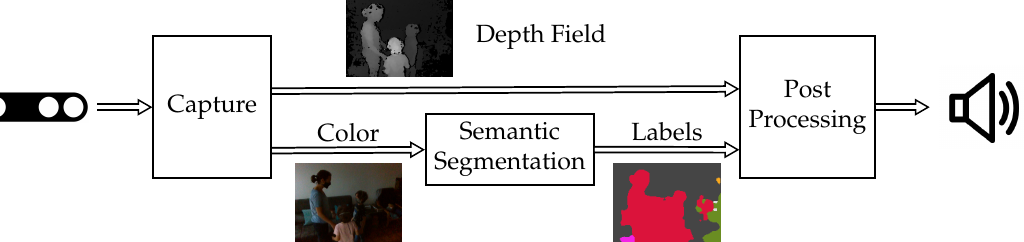
Figure 4. Software architecture. The capture module is implemented in C++ and provides aligned depth and color images. The color image is used by the semantic segmentation module, coded in PyTorch, to generate pixel-wise object class labels. The post-processing module combines the depth field and the label information to provide alerts only for close persons. Communication is handled by the Robotic Operating